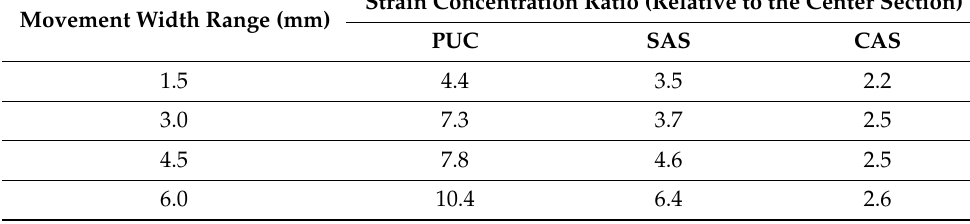
Table 6. Strain concentration ratio comparison of the waterproofing materials.